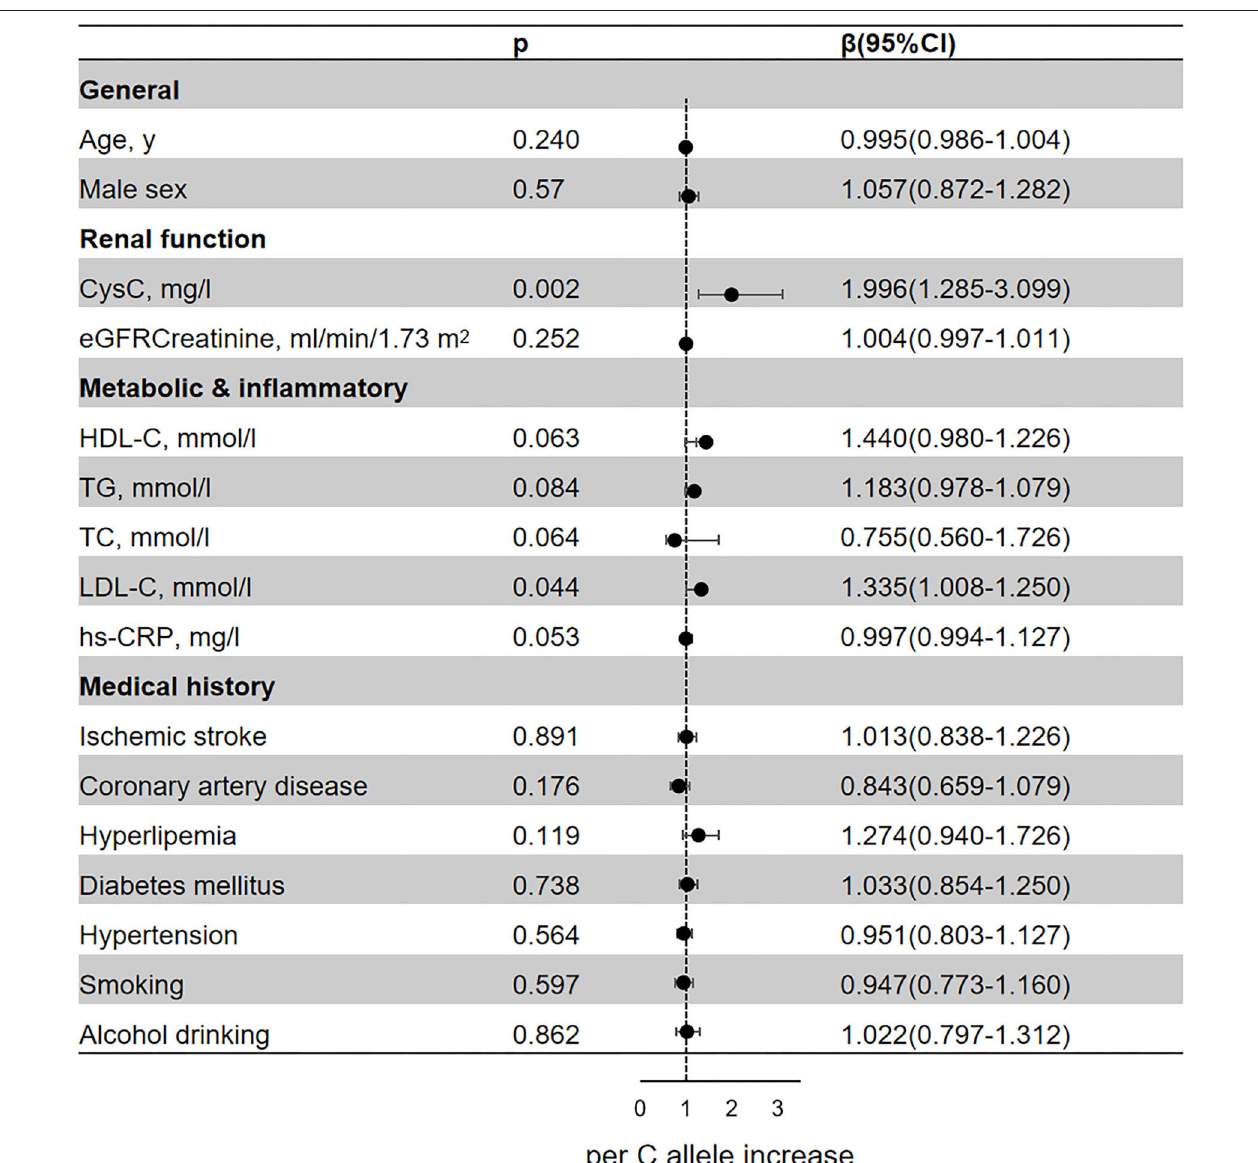
FIGURE 2 | Association of the genetic variant (rs13038305 polymorphisms) with cardiovascular risk factors and traits. Effect sizes ( β ) are presented as standard deviations of each trait per major allele to facilitate comparison between traits. Adjusted for age, sex, CysC, eGFRcr, HDL-C, TG, TC, LDL-C, hs-CRP, smoking, alcohol drinking, ischemic stroke, coronary artery disease, hyperlipidemia, diabetes mellitus, and hypertension. BMI, body mass index; CysC, cystatin C; eGFRcr, creatinine-calculated estimated glomerular filtration rate; LDL, low-density lipoprotein; HDL, high-density lipoprotein; TG, triglyceride; TC, total cholesterol; hs-CRP, high-sensitivity C-reactive protein; CI, confidence